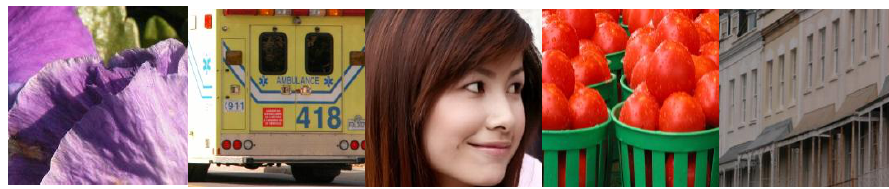
Figure 4. Some training samples for dictionary learning.